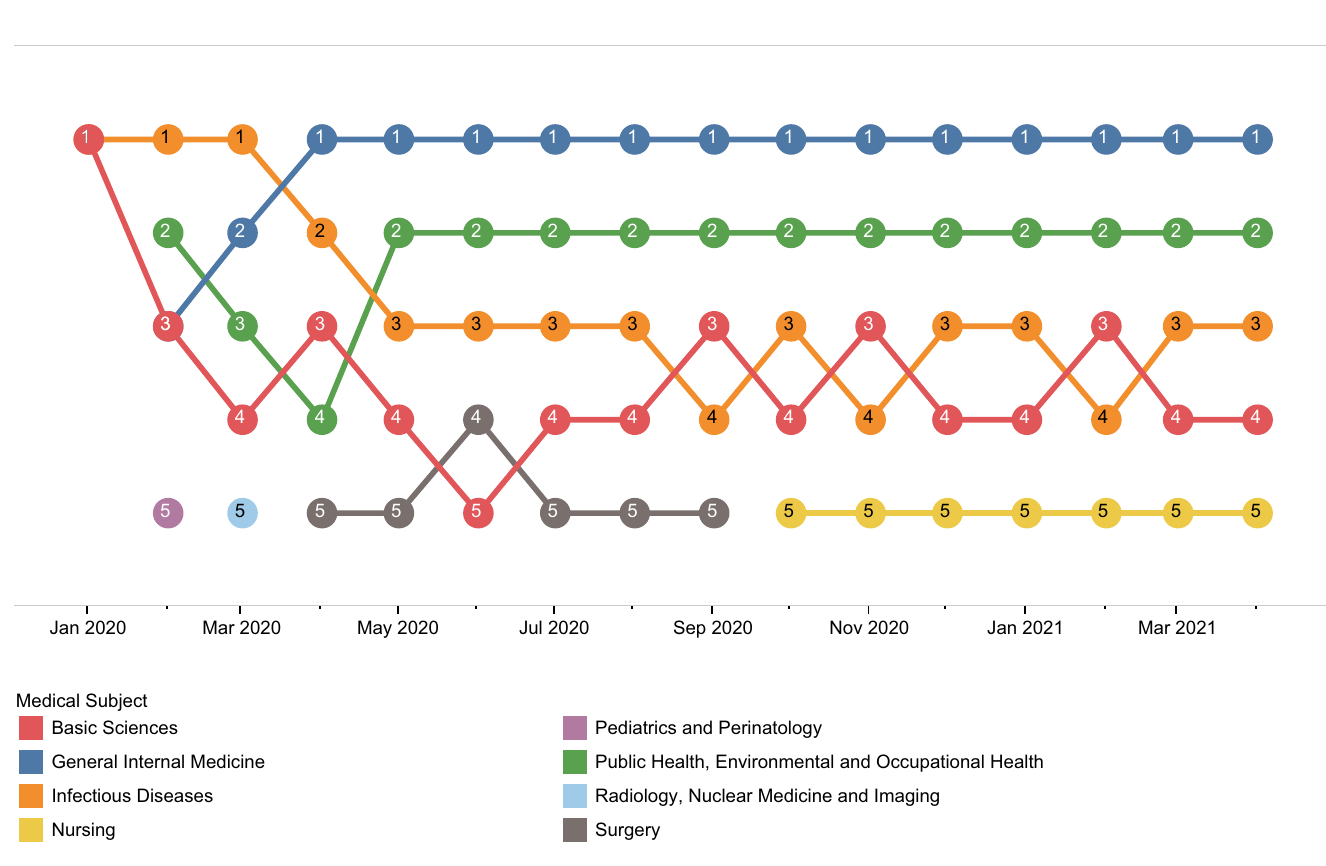
Fig 6. Monthly ranking of the top five medical subjects in publications.